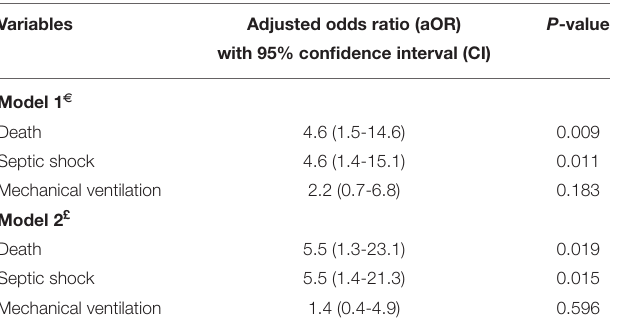
TABLE 4 | Multivariable Logistic Regression Analysis of elevated red blood cell distribution width (RDW) value.